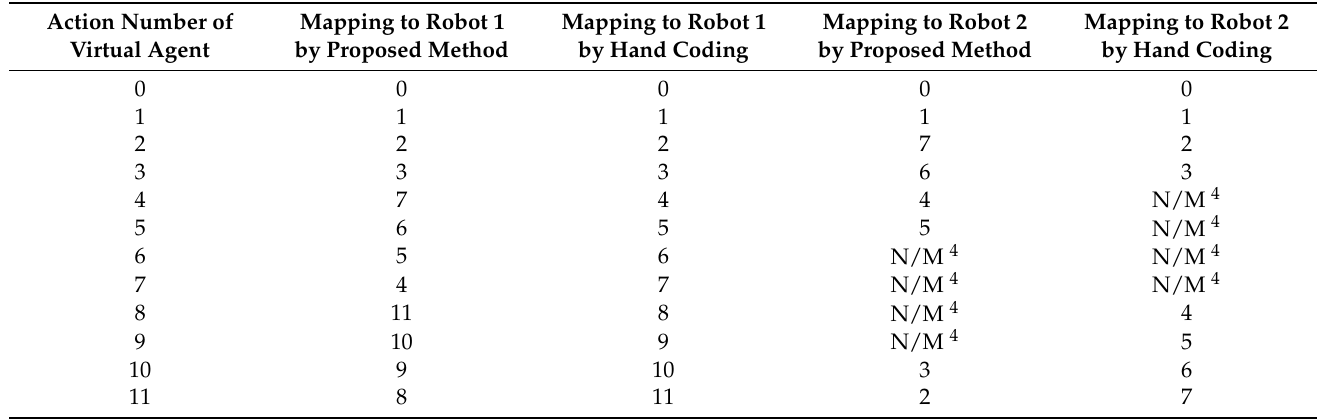
Table 5. Results of mapping using each body diagram and hand